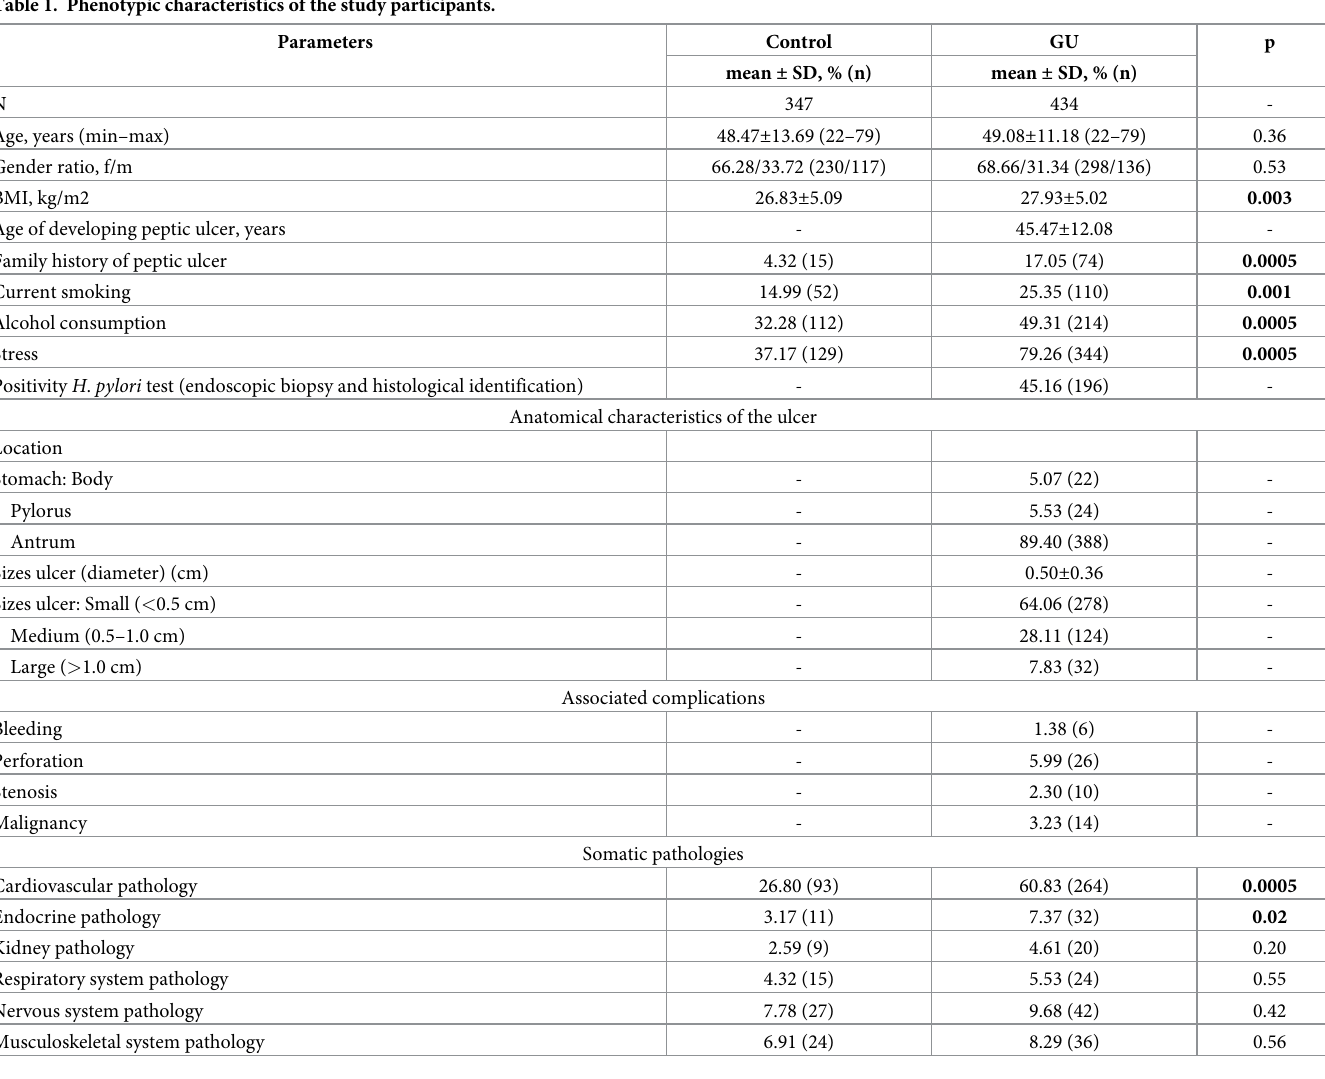
Table 1. Phenotypic characteristics of the study